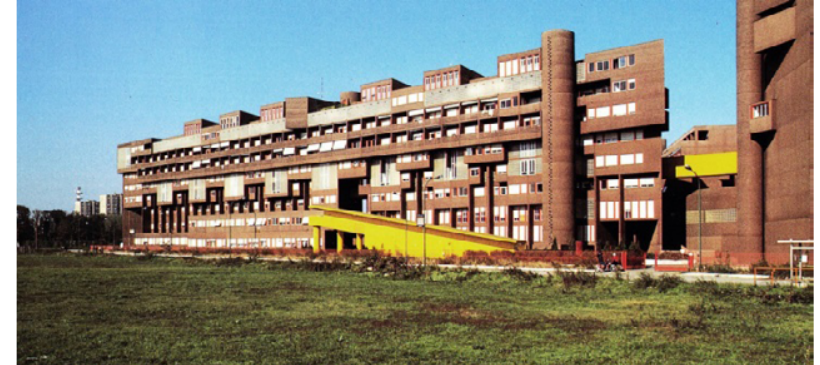
Gallaratese (Milano) [Picture taken from: http://www.atlantedellarteitaliana.it/